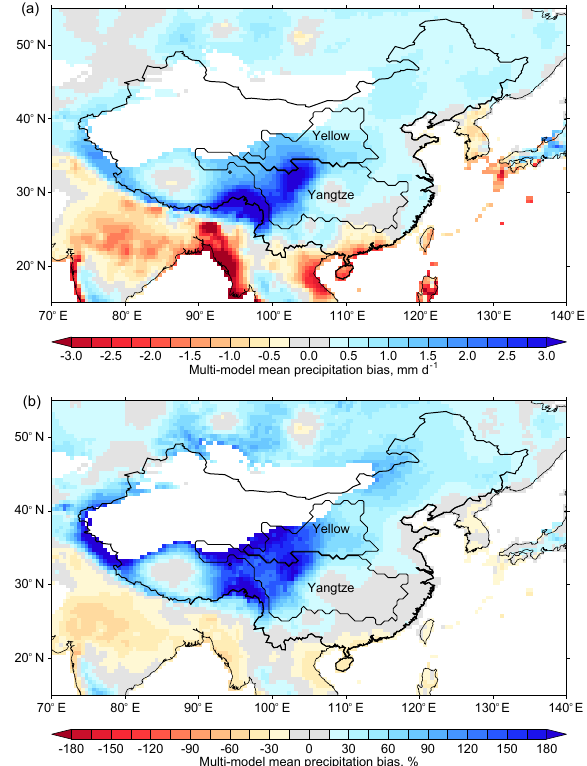
Figure 7. Absolute (a) and relative (b) multi-model mean precipi- tation climatology bias for 1961–1990. The location of the Yangtze and Yellow River catchments within China is shown. Desert regions ( < 200mmyr − 1 ), as determined from CRU climatology (1961– 1990), are masked in